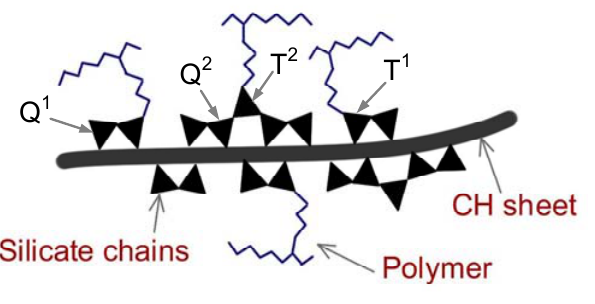
Figure 4. Schematic of polymer groups grafted at T silicon sites